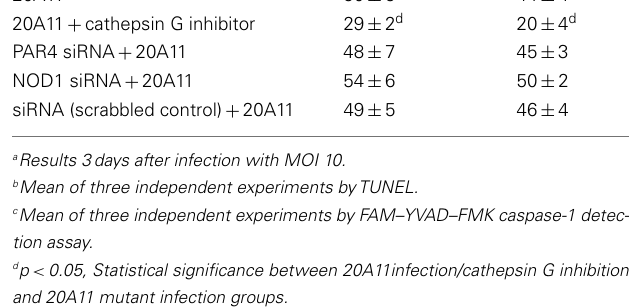
FIGURE 6 | Colocalization of Rv3364c with the cathepsin G protein. U937 cells were transiently coinfected with Lenti-X viruses produced from a pLVX–ZsGreen1–cathepsin G vector and either a pLVX–dtTomato (A–D) or pLVX–dtTomato-Rv3364c fusion vector (E–H) . ZsGgreen1-labeled cathepsin G visualization show punctate pattern in transduced cells (B,F) . dtTomato